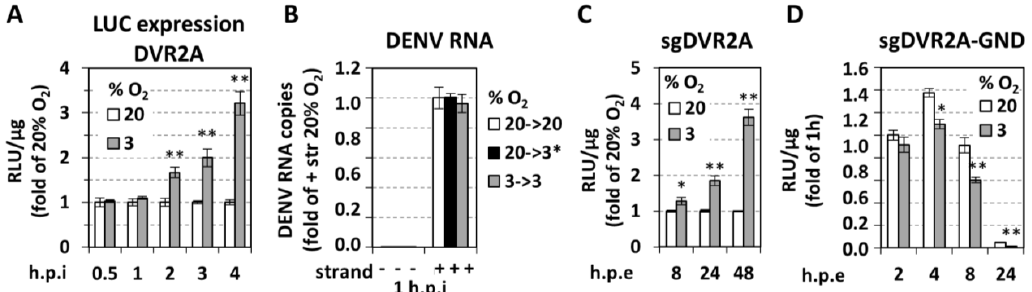
Figure 3. Low oxygen tension selectively enhances DENV RNA replication. ( A ) Huh7 cells preincubated at 20% or 3% O 2 for 18 h were inoculated with DVR2A (MOI = 1) and lysed at the specified time-points post inoculation. Luciferase activity is expressed as RLU/μg of total protein amount and values obtained with 20% O 2 cells were set for each time point to one. ( B ) Hypoxia does not influence viral entry. RT-qPCR analysis of intracellular DENV positive (+) strand RNA copies from Huh7 cells that were inoculated with DENV at MOI = 1 and incubated for 1 h as specified. 20 → 3*% O 2 refers to cells that were preincubated at 20% O 2 and transferred immediately after virus inoculation from 20% to 3% O 2 . Negative (−) strand RNA was quantified in order to indicate the absence of viral replication at 1 h post-inoculation. Values are expressed relative to the positive-strand RNA obtained at 20 → 20% O 2 . ( C , D ) Hypoxia increases viral RNA replication but not translation. Huh7 cells preincubated at 20% or 3% O 2 for 18 h, were electroporated (5 μg RNA/4 × 10 6 cells) with subgenomic sgDVR2A (sgDV, C ) or its replication defective variant, sgDVR2A-GND (GND, D ), and further incubated at the preincubation conditions. Cells were lysed at the indicated time-points and luciferase activity is expressed as RLU/μg of total protein amount. Luciferase levels measured one hour post-electroporation (h.p.e.) were used for normalization for each construct and oxygen condition. For sgDV ( C ), values obtained at 3% O 2 are expressed as fold of the respective ones at 20% O 2 . For GND (D), values obtained under 20% O 2 at 2 h, were set to 1. In all panels, bars represent mean values from at least three independent experiments in triplicate. Error bars indicate standard deviations. * p < 0.01, ** p < 0.001 vs. 20% O 2 cells (Student’s t -test).